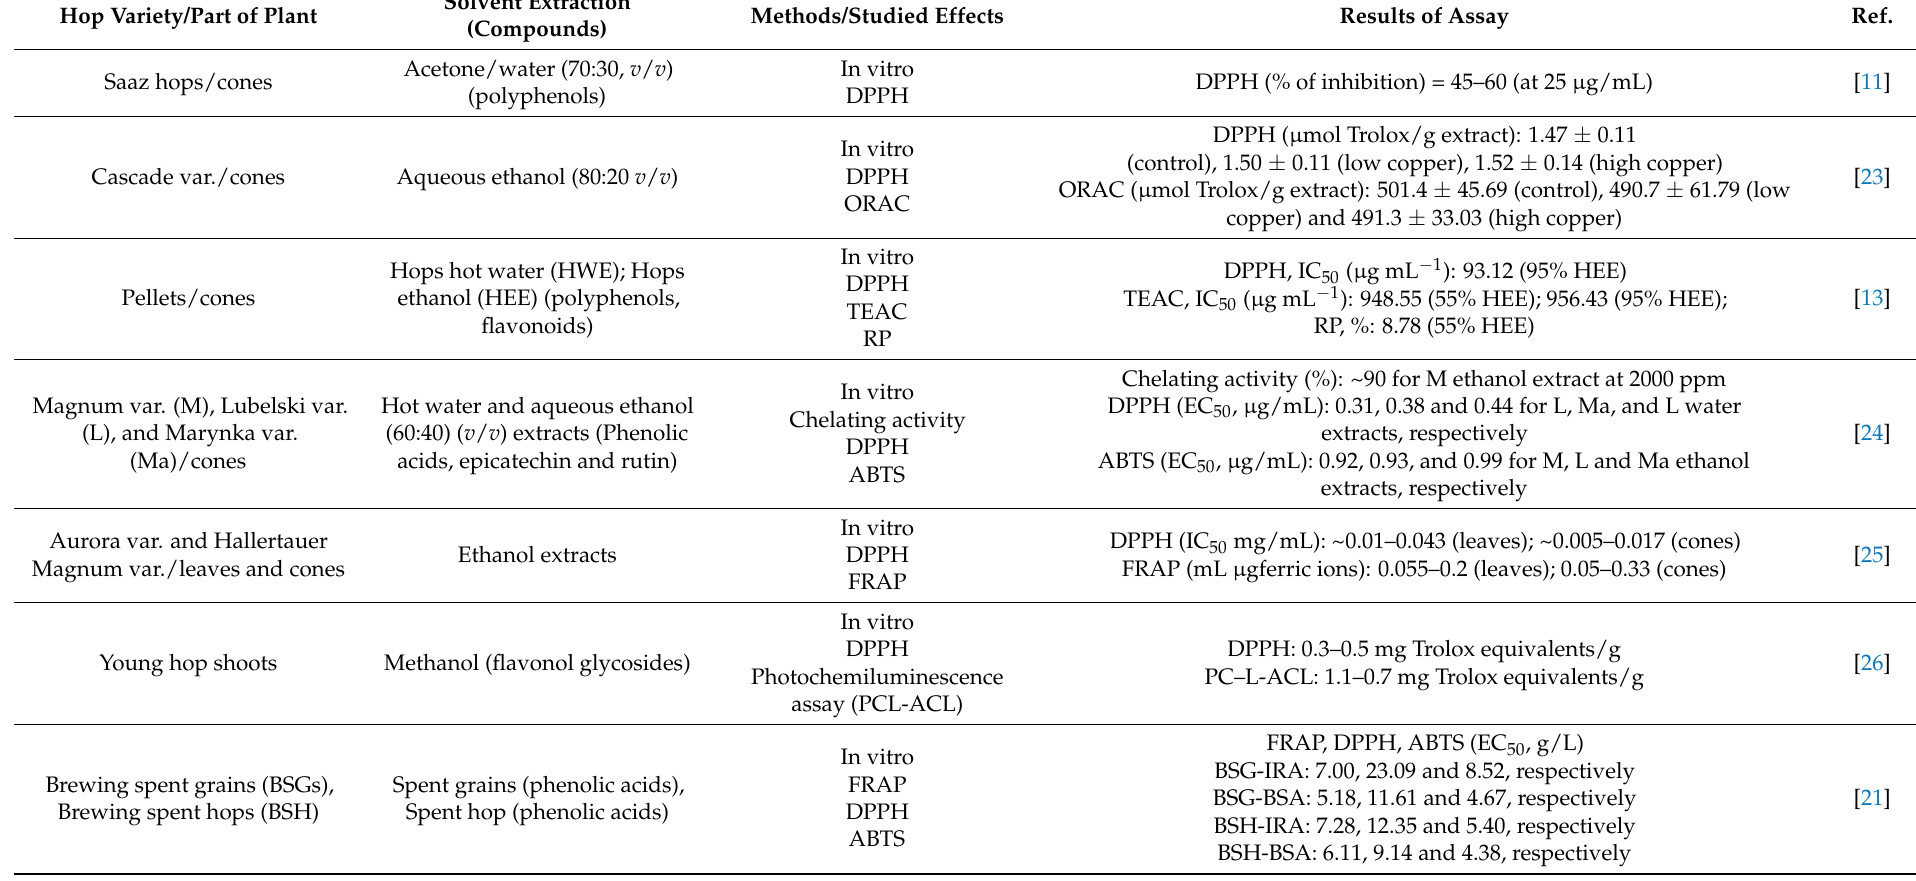
Table 1. Antioxidant activities of hop